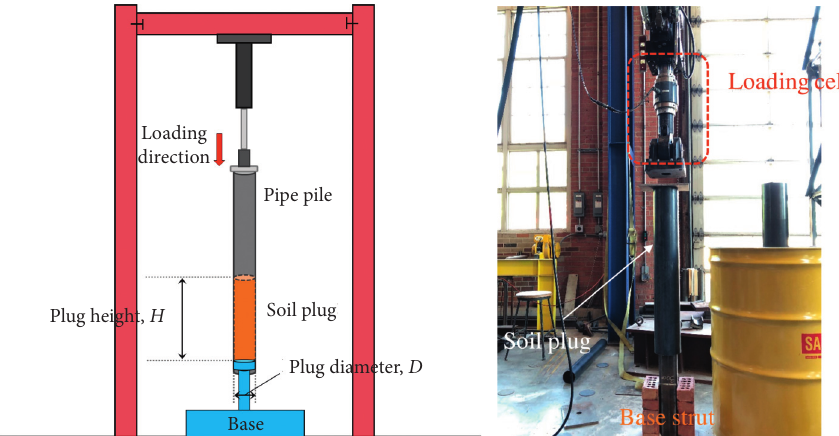
Figure 5: Experimental setup of the soil plug resistance test.